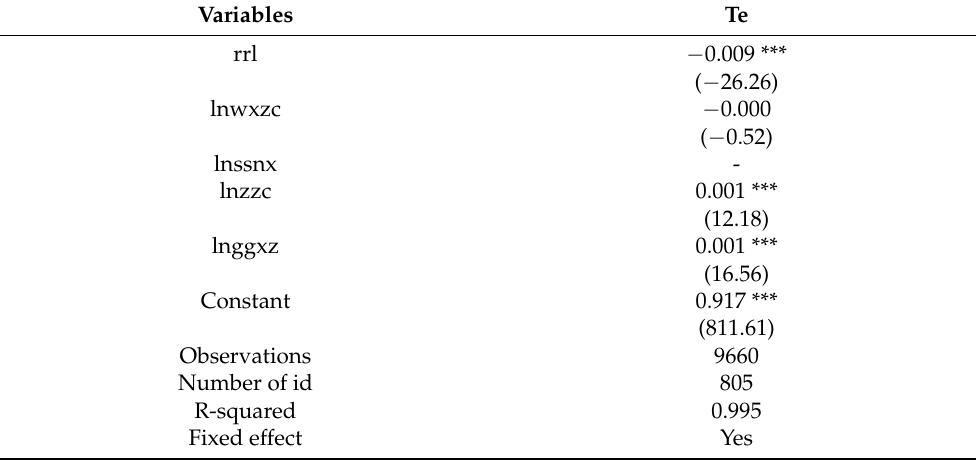
Table 5. Robustness